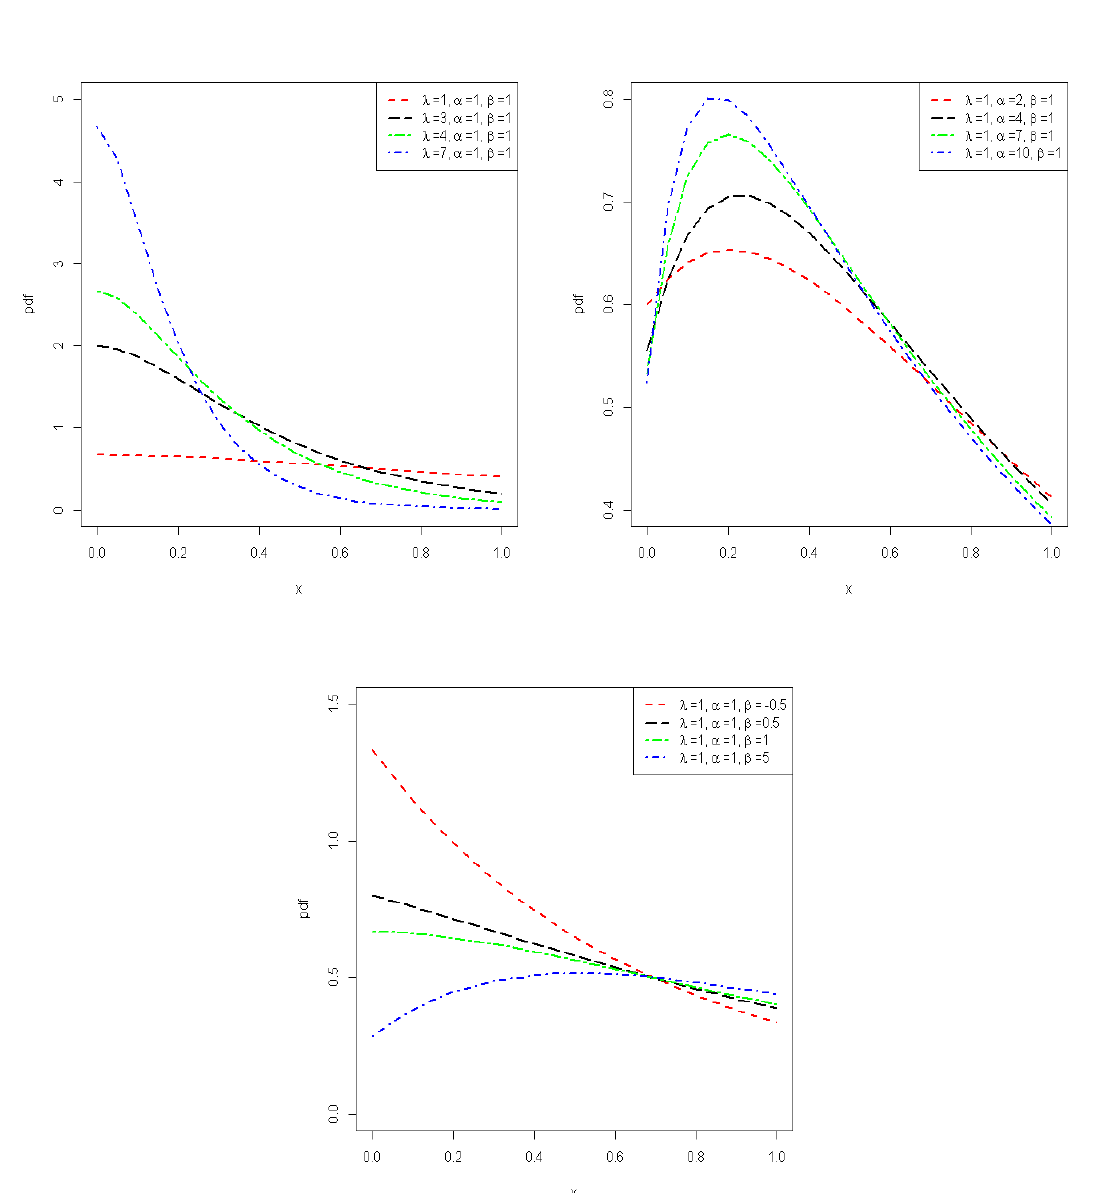
Figure 1. The pdf curves for different parameters of GME ( λ , α , β )